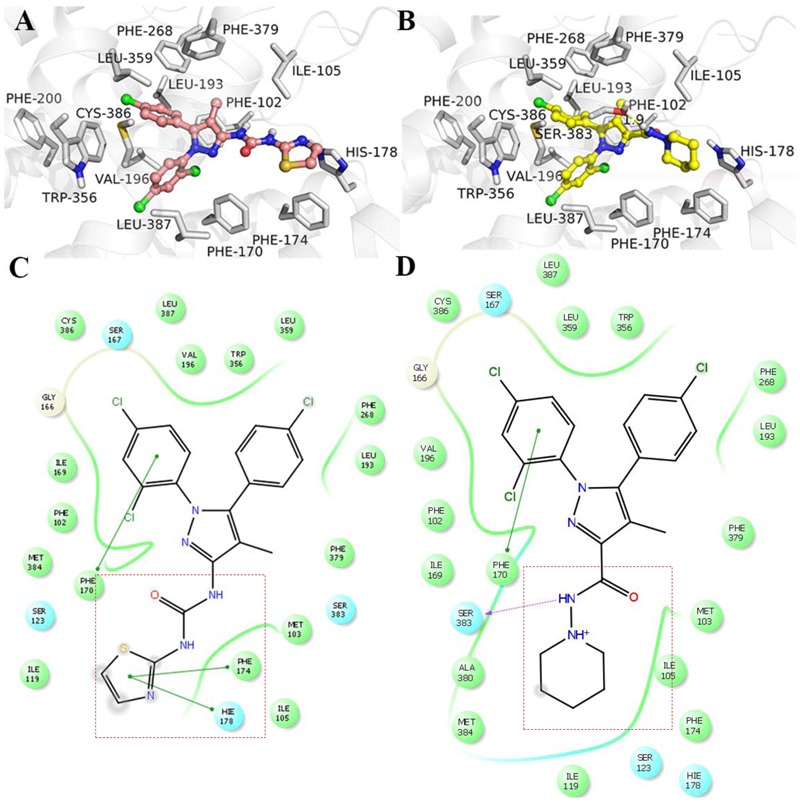
Interaction with cannabinoid receptor 1 (CB1R). (A) TXX-522 and (B) SR141716A docking with the CB1R. Two-dimensional topological representation of (C) TXX-522 and (D) SR141716A docking with CB1R.